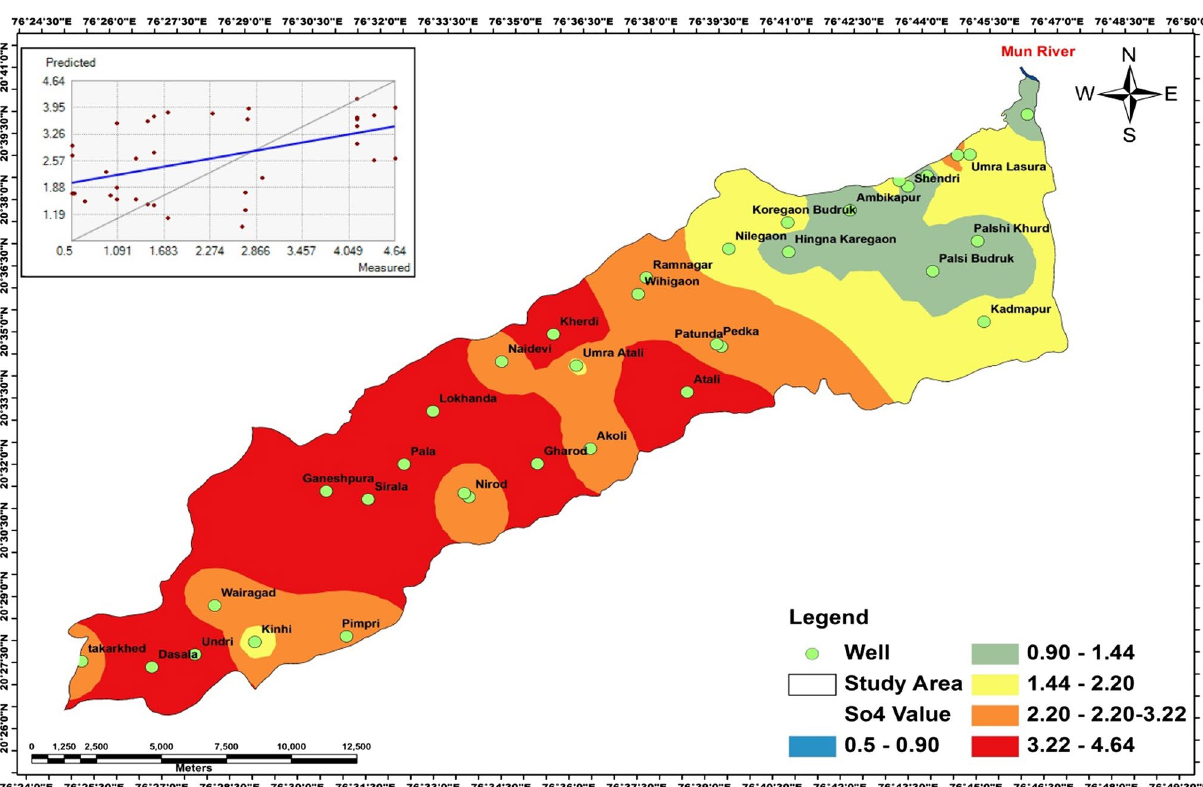
Fig. 11 Spatial distribution map of So